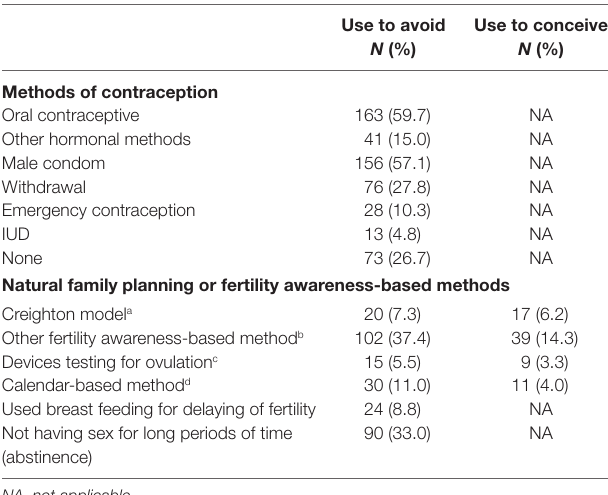
TaBle 3 | Prior use of family planning methods, reported on the entrance questionnaire ( N = 273 women).